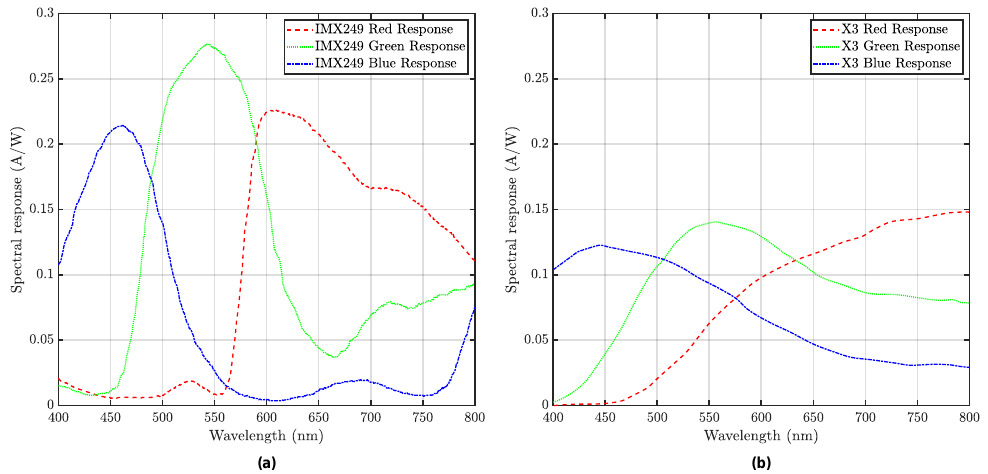
Figure 1. Image sensor filter responses. These graphs illustrate the product between filter transmis- sivity and silicon sensor responsivity. ( a ) Sony IMX249. ( b ) Foveon X3. Dashed line, dotted line, and dash-dot line correspond to red, green, and blue,